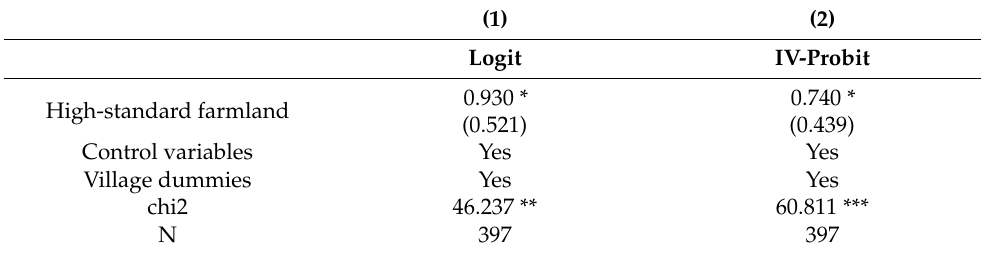
Table 3. Robustness analysis results of CHSF for